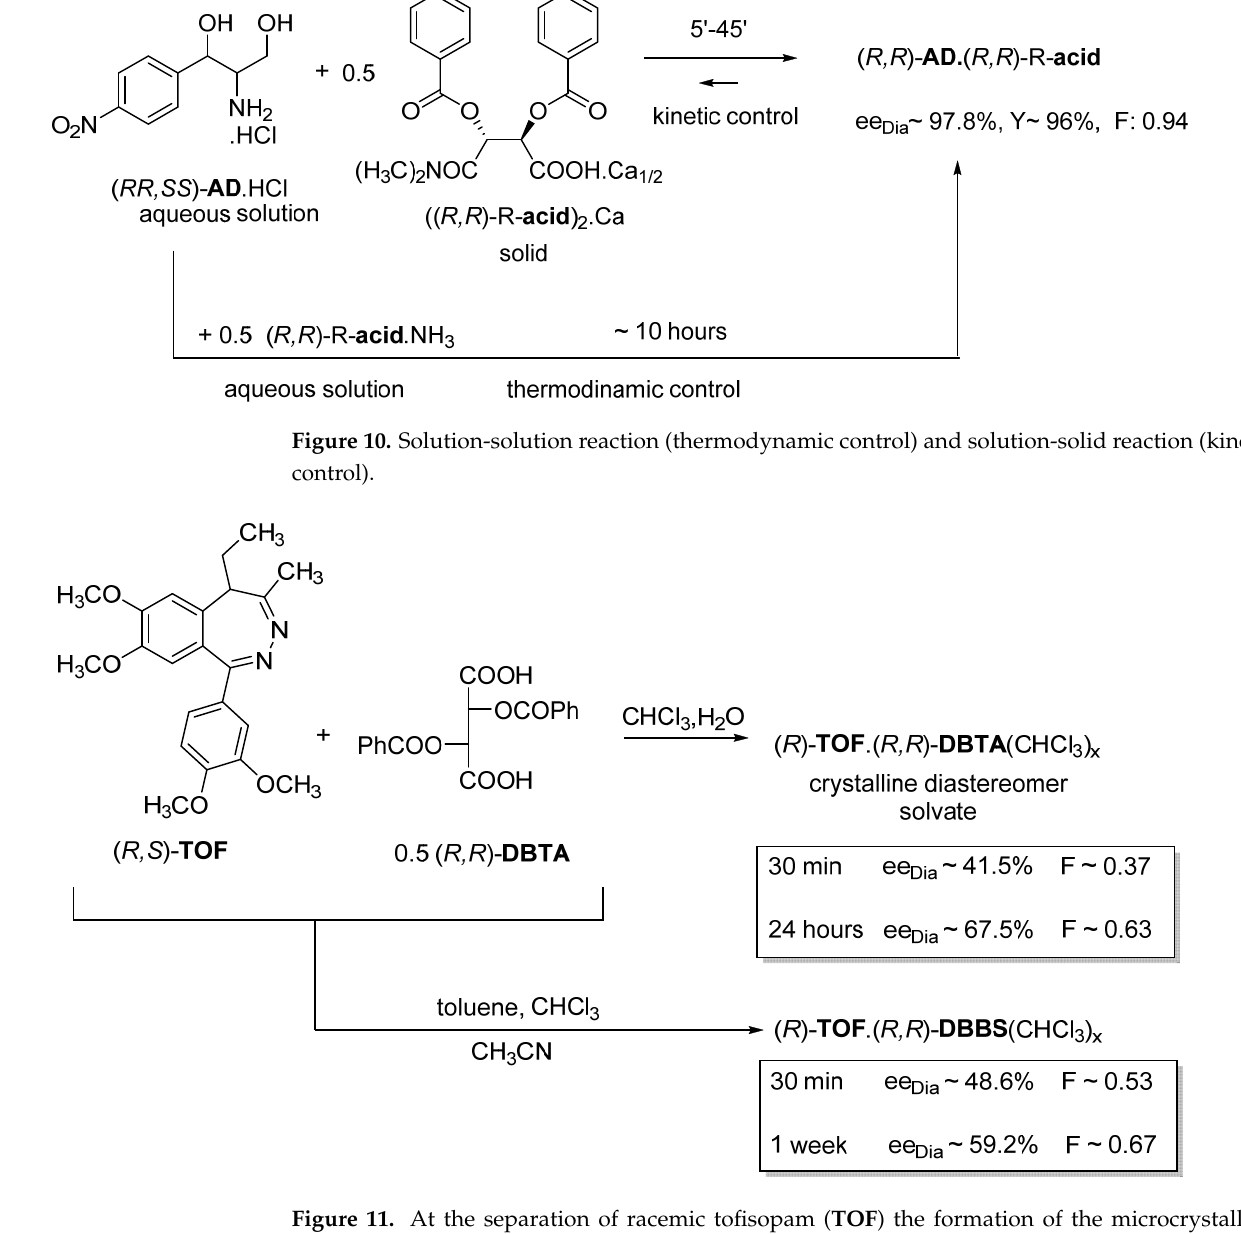
Figure 11. At the separation of racemic tofisopam ( TOF ) the formation of the microcrystalline dia- stereomer does not occur without a solvate-forming solvent.